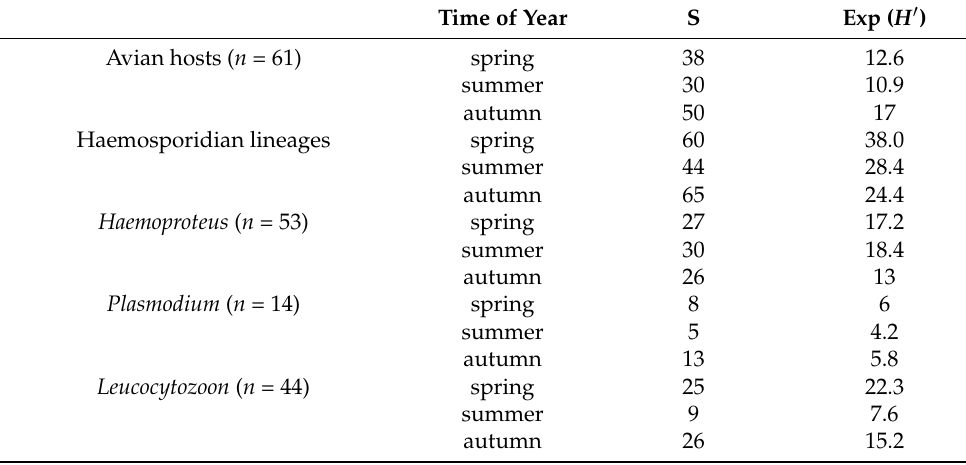
Table 2. Richness (S) and diversity of avian host species and haemosporidian cytochrome b lineages detected in Drienovec, Slovakia, during 2017, 2018 and 2019. Taxonomic diversity was examined in terms of the Exp ( H (cid:48) ) index, reflecting the effective number of species based on the Shannon diversity index H’ for the given taxonomic group and time of